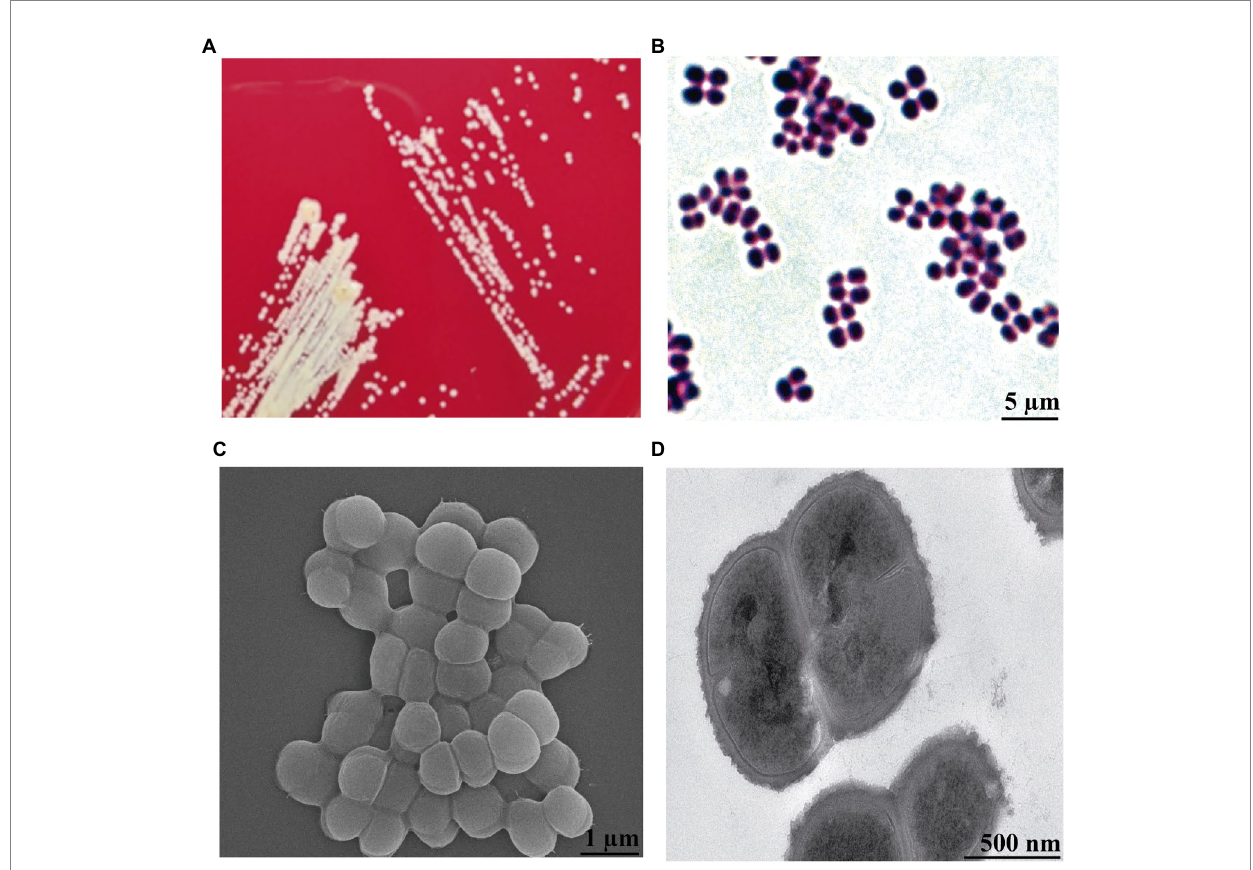
FIGURE 2 Morphology observation of K. kristinae_LC by cultivation, Gram staining, SEM and TEM. (A) Colonies of K. kristinae_LC on blood agar plates. (B) Gram staining of the bacteria was observed as blue-purple under microscopy, which demonstrated that this bacterium is Gram-positive. Morphology observation of the bacteria by SEM (C) and TEM (D)